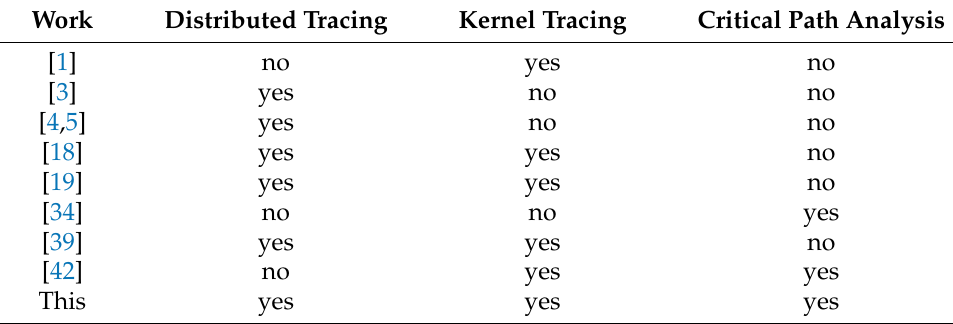
Figure 2. View of our requests critical path analysis in Trace Compass. Each state has a different colour—green for RUNNING , orange for PREEMPTED , grey when blocked by another request, etc.—and the arrows indicate how the different requests intersect in their respective critical path. Instead of showing a single request only, our view includes all the requests that happened in parallel. Table 1. Comparison with selected related